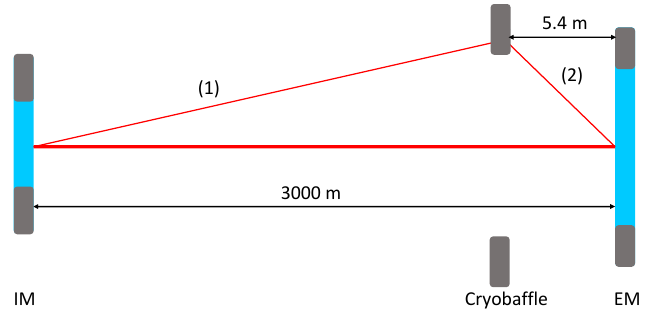
Figure 1. Position of the cryobaffle in one of the main arms. Mirrors are represented in blue and baffles in grey. Scattered light from IM (EM) could back-scatter, following path (1) (path (2)), and recombine to the main beam resonating in the